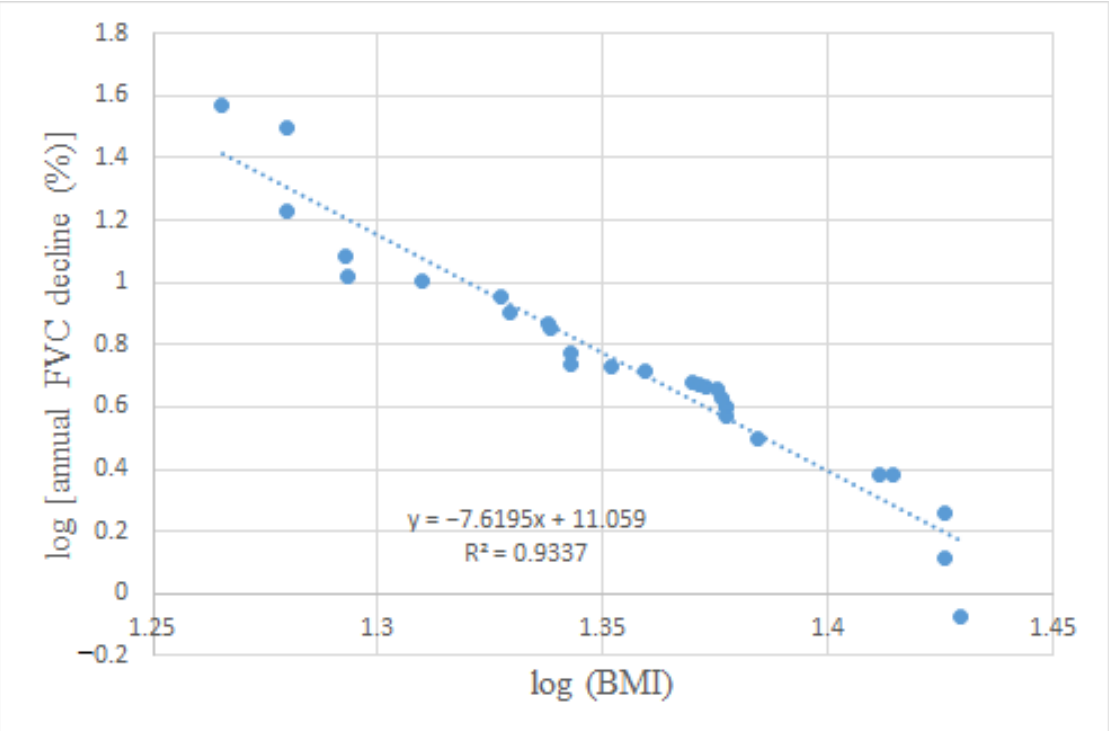
Figure 4. Negative correlation between BMI and annual FVC decline (%) . BMI, body mass index; FVC, forced vital capacity. A total of 10 patients had gastrointestinal involvement (mostly esophagus dysmotil ‐ ity) with a predominantly low or normal BMI ( p = 0.019), compared to overweight pa ‐ tients. No significant association was found between gastrointestinal symptoms and PF ‐ ILD. 4. Discussion SSc ‐ ILD has a variable disease course from slow decline with stable periods or im ‐ provement to rapidly progressive clinical course. The novelty of our study is that baseline overweight might be an important indicator for more favorable outcomes regarding PF ‐ ILD. In our study, 15 patients (35.7%) met our PF ‐ ILD criteria, which is in correspondence with international data [1,3,18–20]. In 2014, Tiffany and colleagues analyzed 27 reviews